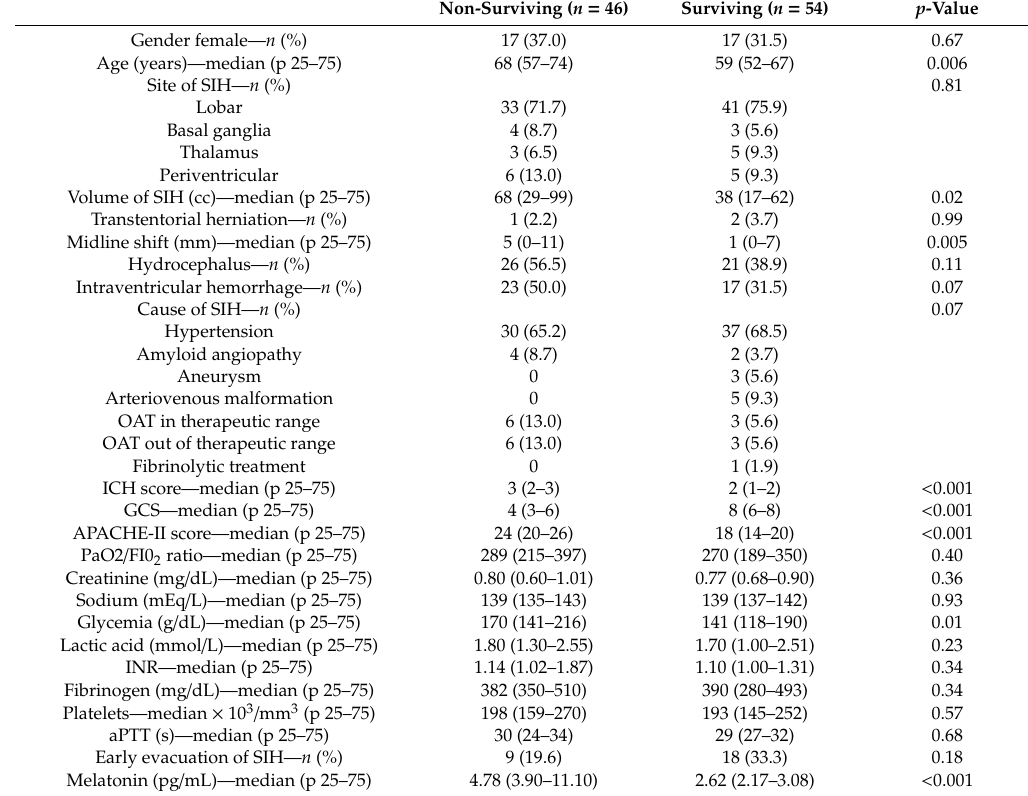
Table 1. Clinical and biochemical characteristics of 30-day surviving and non-surviving patients with spontaneous intracerebral hemorrhage